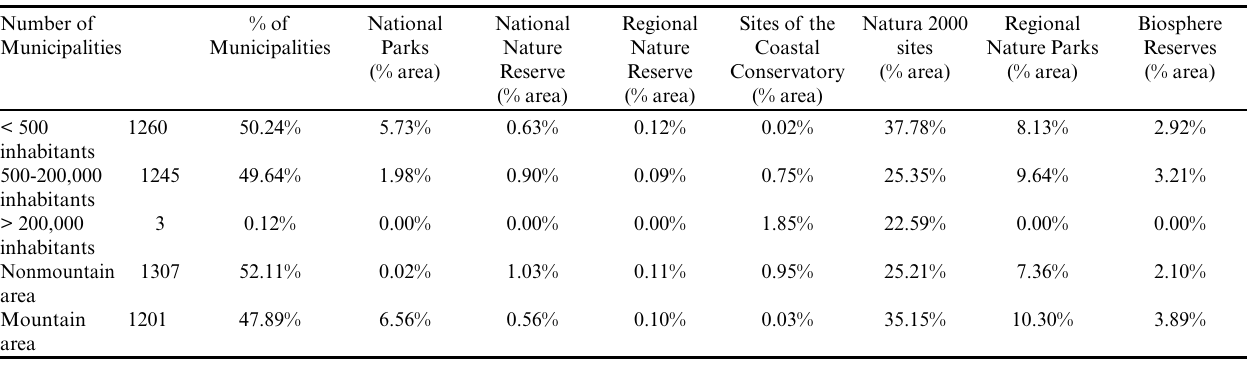
Table 1 . Number of inhabitants in municipalities and percentage of their surface under different types of protection in southern France (Languedoc-Roussillon and Provence-Alpes-Côte d’Azur regions). Number of Municipalities